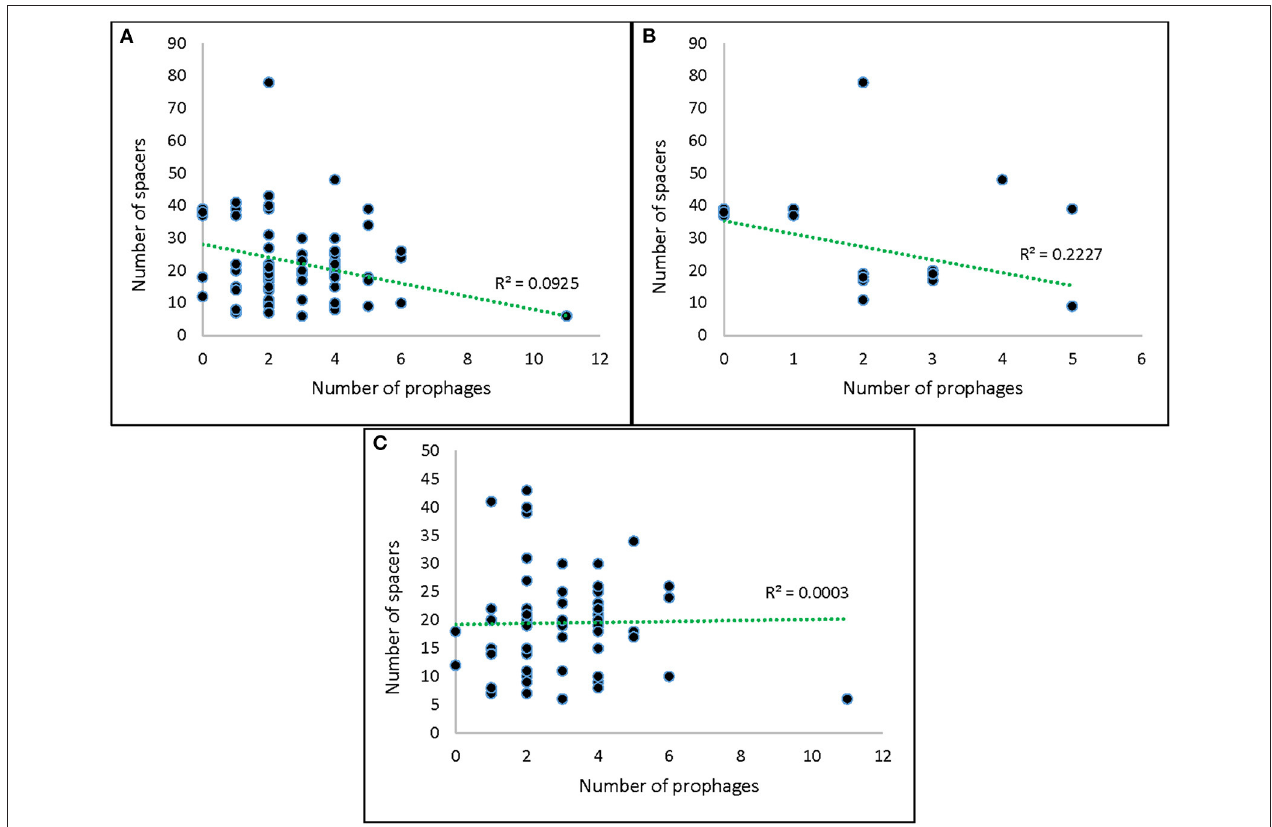
FIGURE 7 | Correlation between number of spacers and number of prophages. (A) All strains; (B) Salmonella strains; (C) VTEC